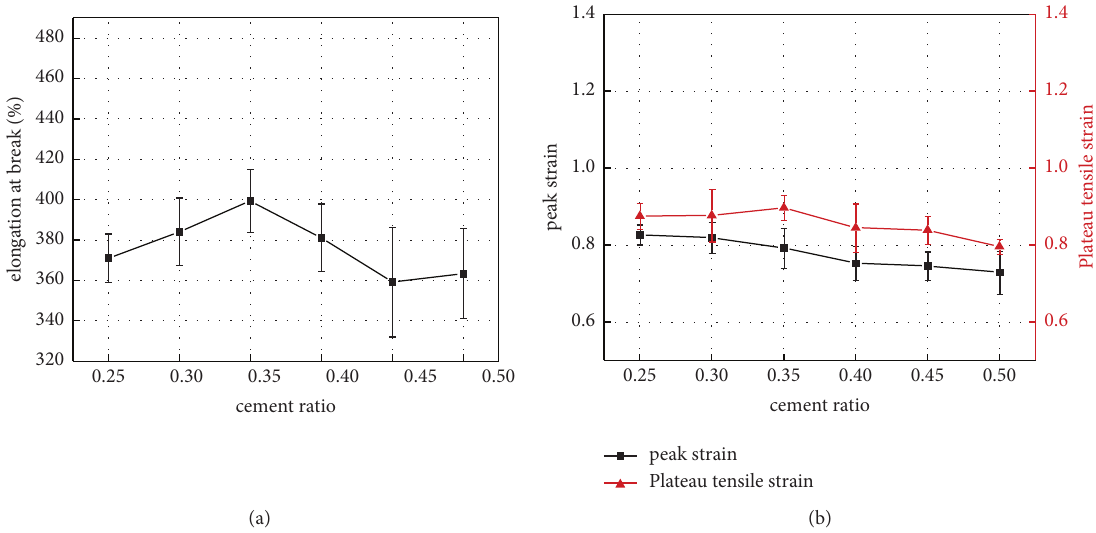
Figure 11: Changes of PCC tensile deformation indexes with cement ratio: (a) elongation at break; (b) peak